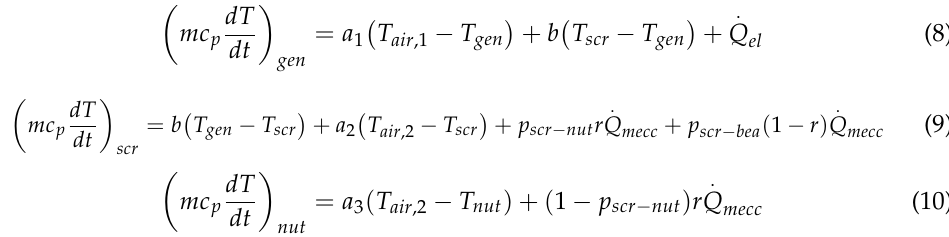
As first attempt, due to their relatively small sizes in the radial coordinate and their high thermal conductivities, the generator, the screw shaft, and the nut are supposed to behave as “lumps” whose internal temperatures remain essentially uniform in space. Un- der such an assumption, the temperature can be taken to be a function of time only [23], and the lumped parameter thermal model reported in the first order linear ODEs (8), (9),